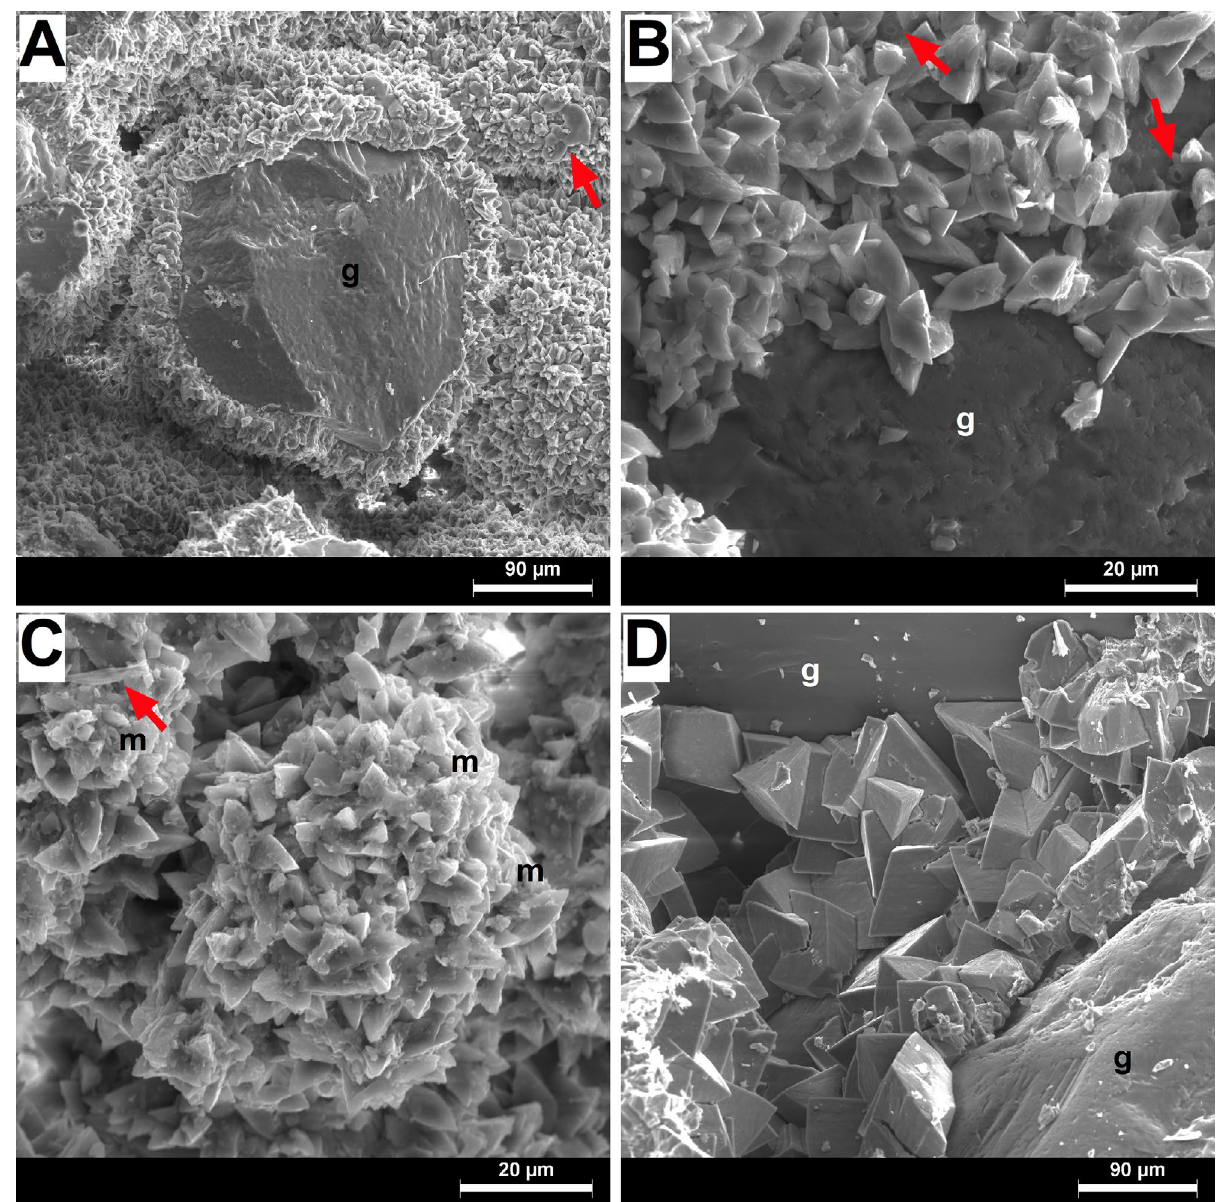
Fig. 7. – Scanning electron microscope (SEM) cements images. A, rhombohedral crystals of HMC cement forming rinds coating sedimentary grains (g), non-crystalline biogenic aggregates (red arrow) (CA11). B, acute rhombohedral crystals of HMC on sedimentary grains (g), coccoliths (red arrows) (CA3). C, rhombohedral crystals of HMC cement partially covered by scattered micrite aggregates (m), diatom frustule (red arrow) (CA7). D, steep rhombohedral crystals (spar) of LMC cement on sedimentary grains (g)